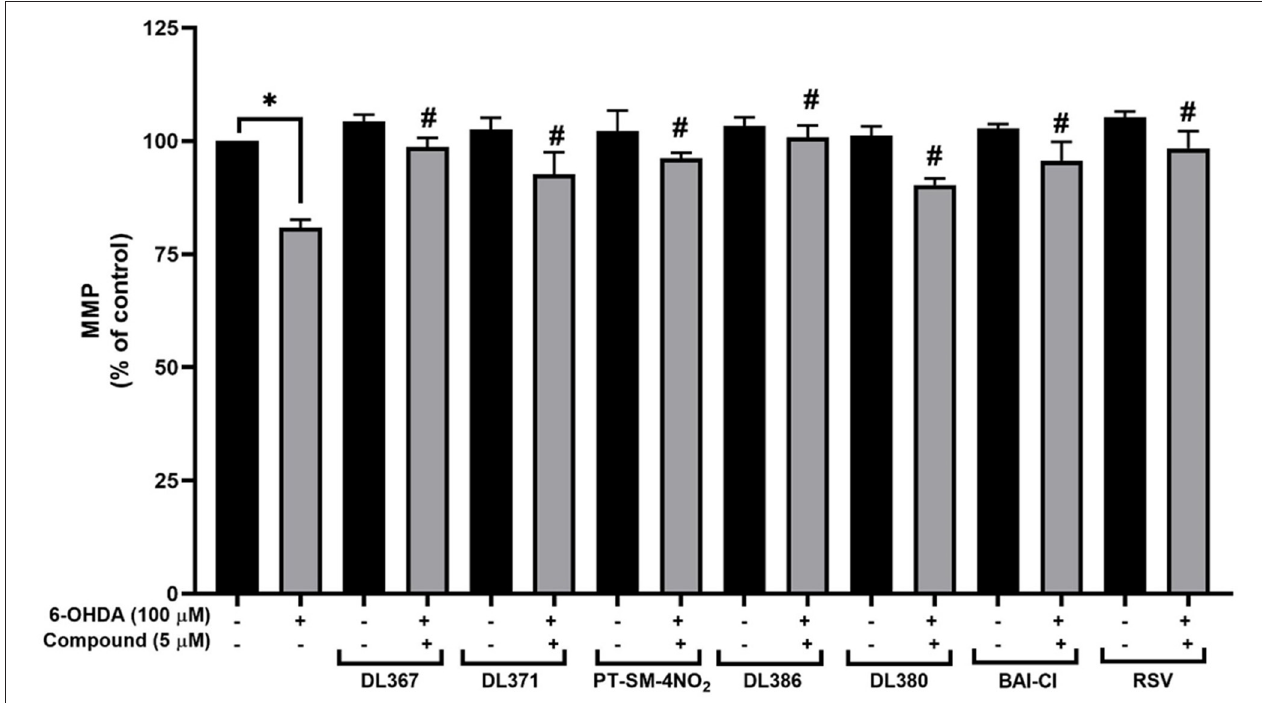
FIGURE 6 | Effects of 5 µ M resveratrol and bis-sulfonamides pretreatment for 3h before exposure to 100 µ M 6-OHDA for 24h of SH-SY5Y cells on the mitochondrial membrane potential (MMP) as measured by the rhodamine-123 fluorescence intensity. The data are expressed as mean ± SEM, and statistical analysis was performed using one-way ANOVA. * P < 0.05 compared with the control cells; # P < 0.05 compared with the